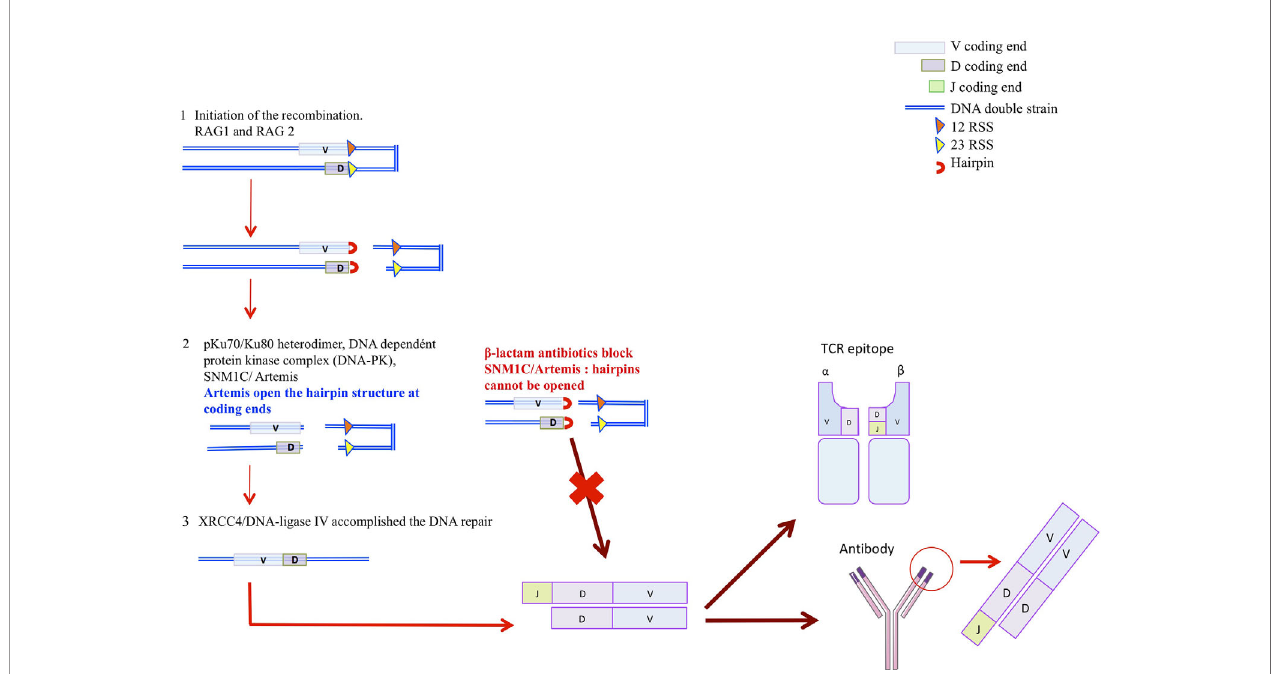
FIGURE 2 | The hypothesis. 1-Lymphoid speci fi c phase is the initiation of the recombination. RAG1 and RAG 2, recognize the recombination signal sequence (RSS) that fl ank all vairable (V), diversity (D), and joining (J) gene units and introduce the DNA double strand break (dsb) at the border of the RSS 2. This phase results on hairpin formation. 2-DNA damage is recognized and hairpin oppened, pKu70/Ku80 heterodimer bonds to the DNA dependant protein kinase complex (DNA-PK) that recognize the DNA dsb. Then the DNA-PKcs is recruited. DNA-PK recruits and phosphoryles SNM1C/Artemis protein that opens the hairpins structures at coding ends 3-DNA reparation is achieved since the XRCC4/DNA-ligase IV accomplished the DNA